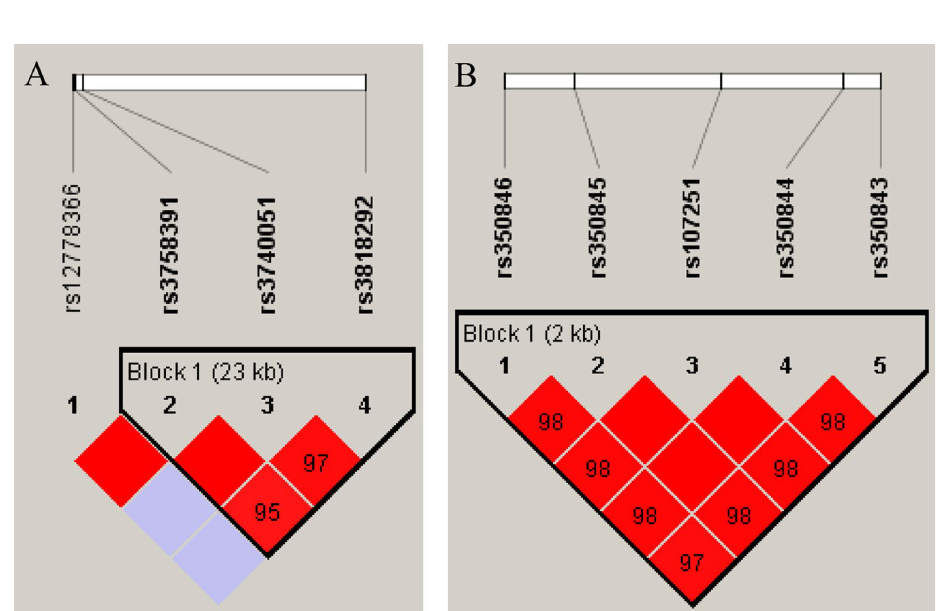
Figure 1. Linkage disequilibrium (LD) plots of single nucleotide polymorphisms (SNPs) of SIRT1 ( A ) and SIR6 ( B ) genes. Shading of diamonds and numbers represent LD between markers based on the D’